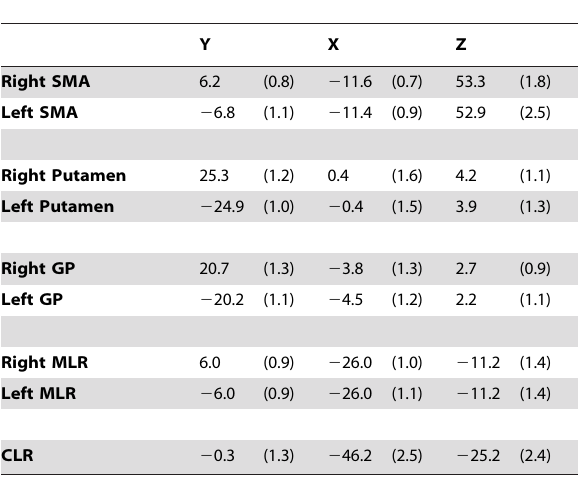
Table 2. Mean (SD) of Talairach coordinates for each region of